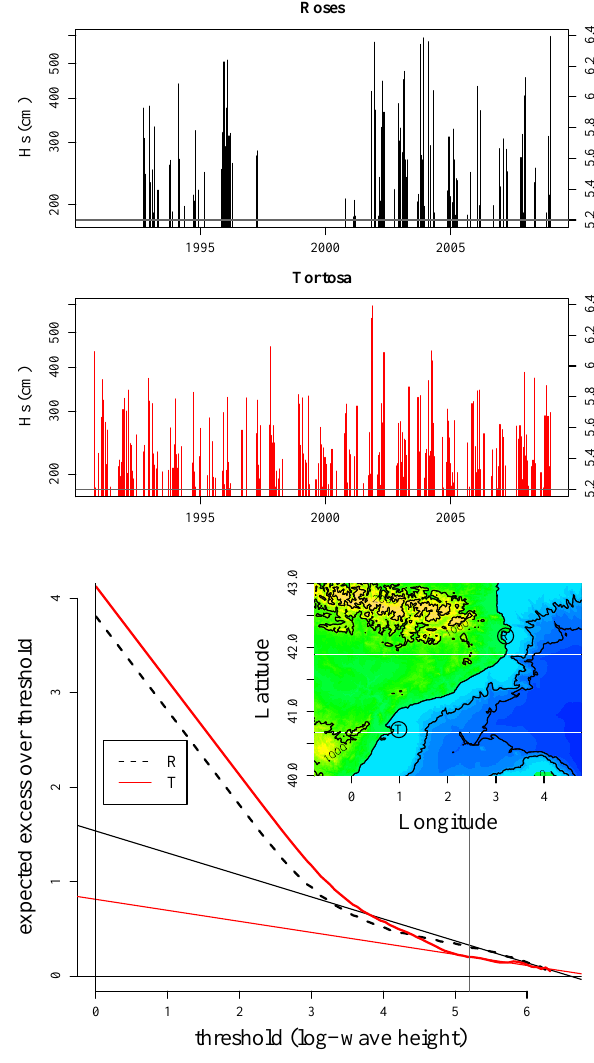
Fig. 2. Significant wave height data series (upper plots), location of the buoys (middle, right plot) and diagram of expected excesses as a function of the threshold (lower plot). This is used to choose the threshold, as (under the hypothesis that excesses are GPD dis- tributed) the function should be a line above it. Dashed/black lines denote Roses, and solid/red ones Tortosa.